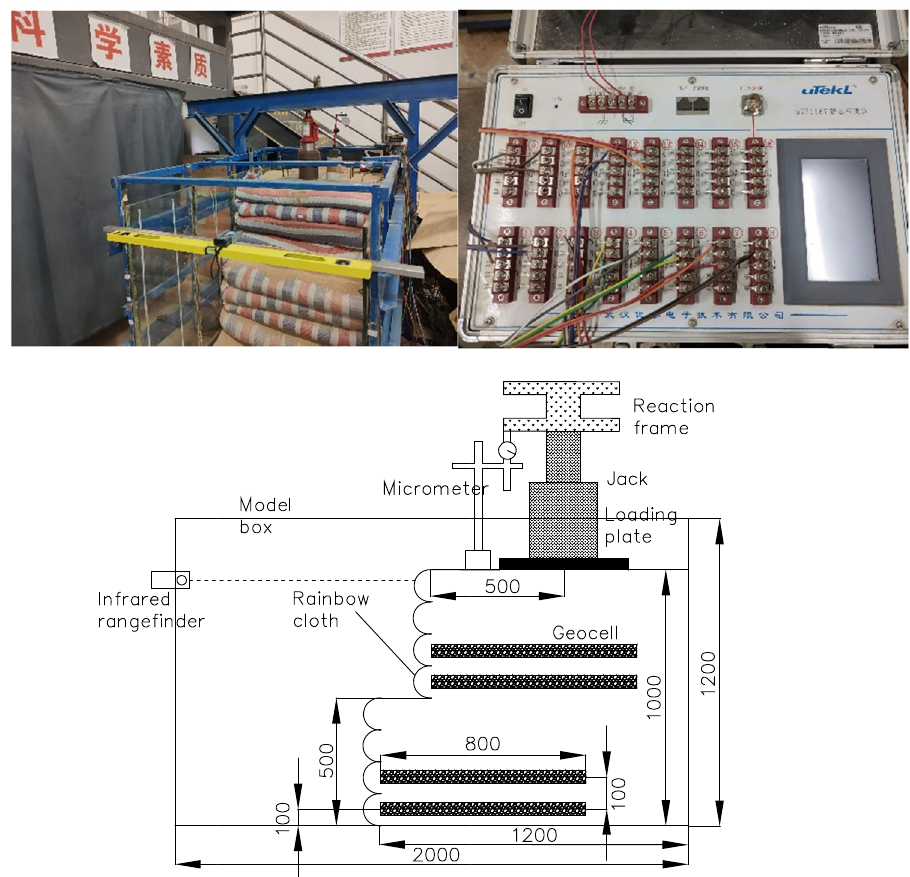
Figure 1: Schematic diagram of test equipment and its model, retaining wall model ( upper - left ) , data acquisition instruments ( upper - right ) , and model diagram ( bottom - middle )